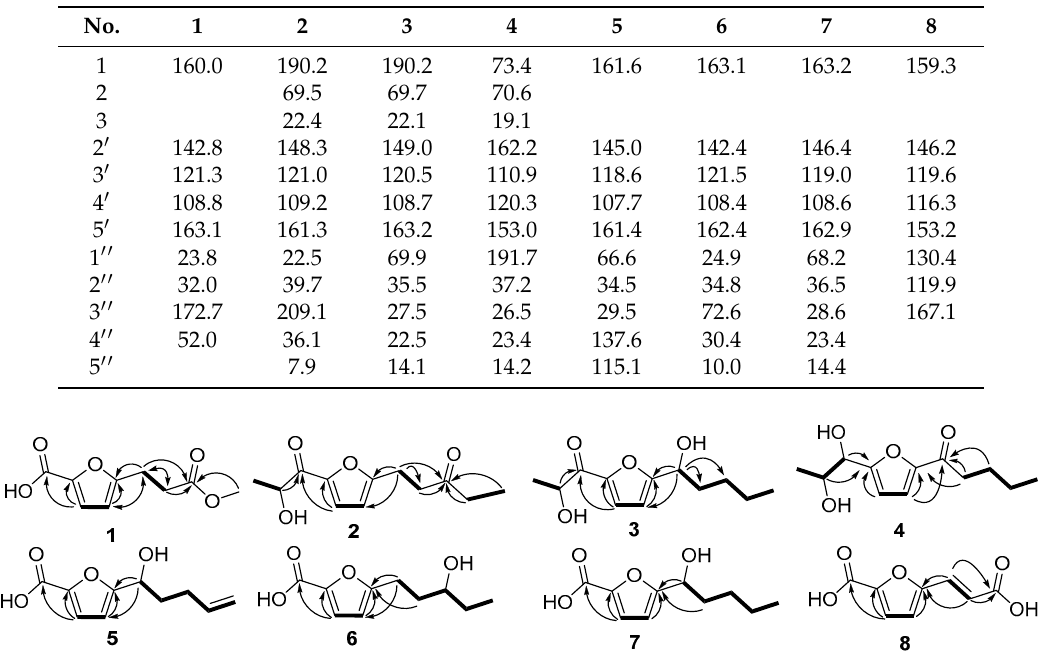
Table 2. 13 C-NMRdata for 1 – 8 ( 1 , 2 , 3 , 5 and 6 in CDCl 3 , 4 and 7 in CD 3 OD, 8 in DMSO- d 6 , 125 MHz, J in Hz, δ in ppm).